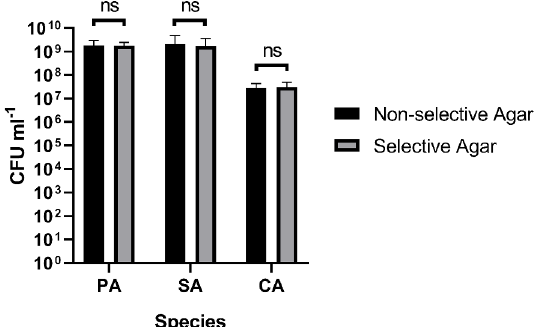
Figure 4. Comparison of cell titres on selective and non-selective agar. The figure shows the viable cell counts (expressed as CFU mL (cid:3) 1 ) of overnight single-species cultures of P. aeruginosa PAO1 (PA), S. aureus 25923 (SA) and C. albicans SC5314 (CA) plated on non-selective agar media (black bars) and selective agar media (grey bars). Data represent the mean (cid:4) standard deviation from two technical replicates collected from three independent biological experiments. P > 0.05 is considered as not significantly different